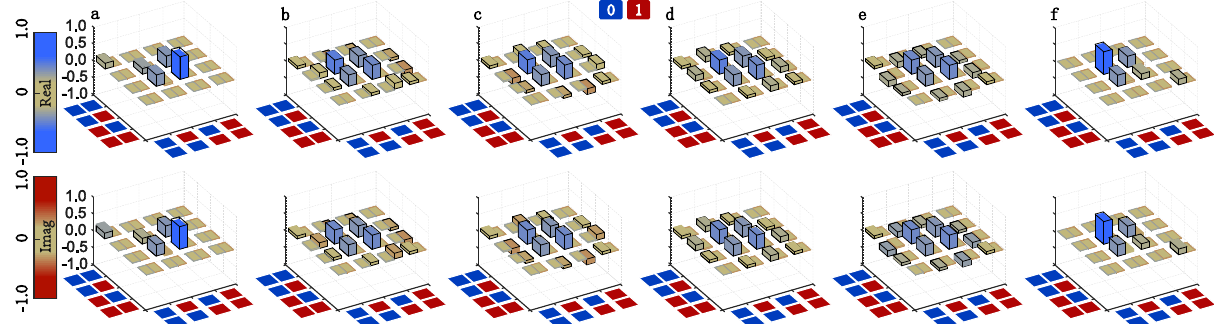
Fig. 4 Measured Q 1 – Q 2 and Q 1 – Q 3 output density matrices for input states. a 0 1 j i ;